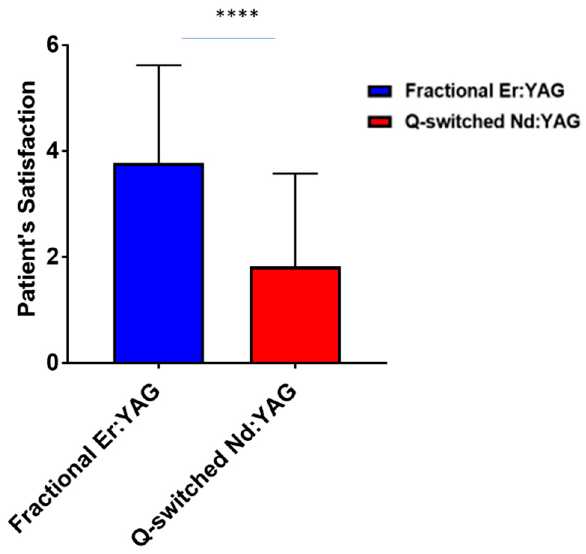
Figure 3. Patient satisfaction based on the treatment outcomes between Q-switched Nd: YAG (1064 nm) and fractional Er: YAG (2940 nm) lasers. **** p < 0.0001.